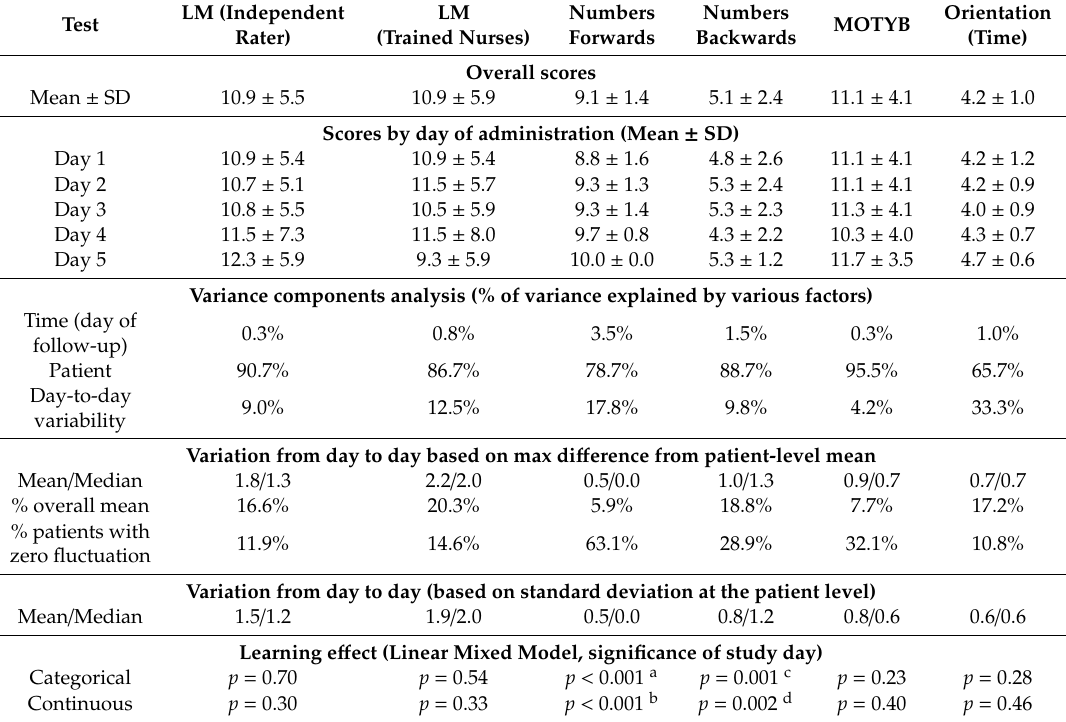
Table 2. Variation analysis with mean ± standard deviation (SD) scores for each test over time including logical memory (LM), numbers forwards and backwards, months of the year backwards (MOTYB), and orientation to